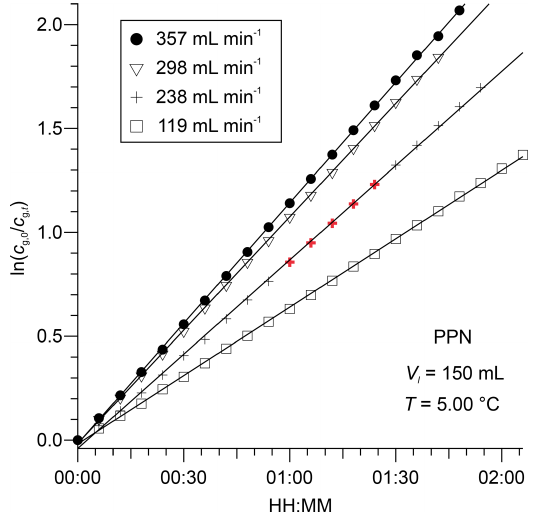
Figure 3. Plots of ln( c g , 0 /c g ,t ) for PPN versus t , observed down- stream from 150mL of DI water at 5.00 ◦ C for four different volu- metric flow rates. The data from Fig. 2 are highlighted in bold and red colour.